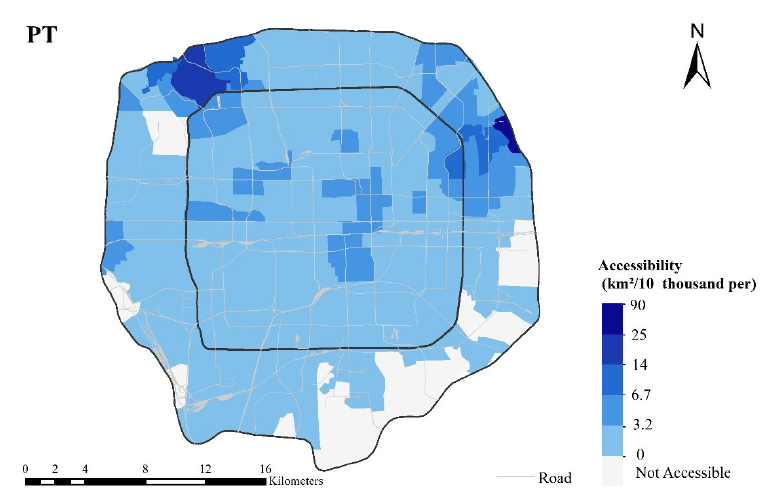
Figure 8. The accessibility results of biking.